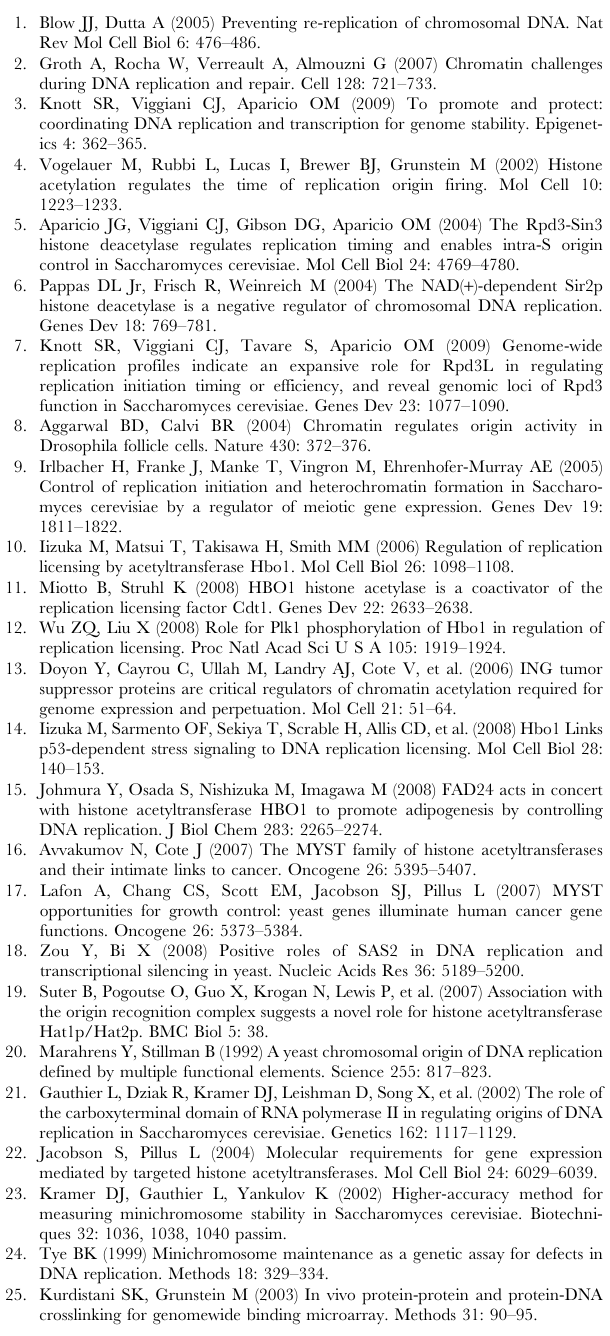
Found at: doi:10.1371/journal.pone.0008964.s002 (0.03 MB